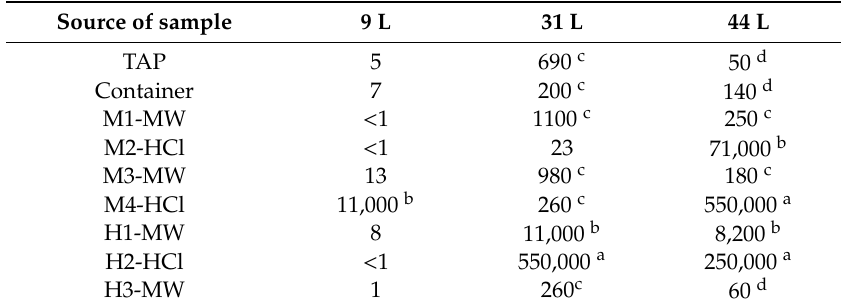
Table 6. Comparison of removal e ffi ciency of TBC by ODTMA granules after the second regeneration (CFU per mL): number of emerging bacteria after passage of given volumes *. Source of sample 9